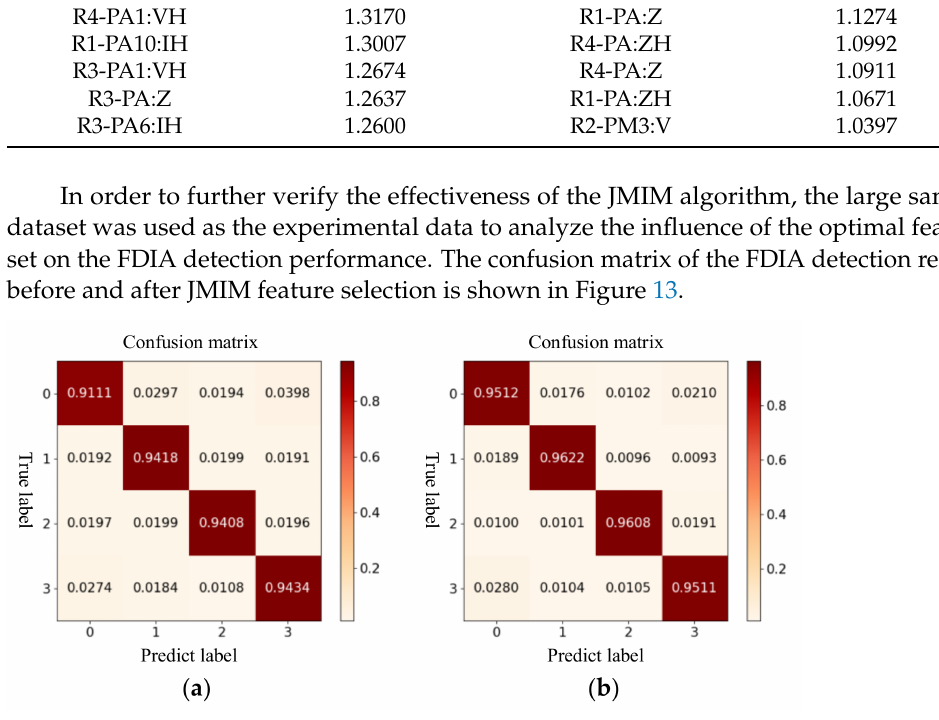
Figure 13. Comparison of FDIA detection results before and after feature selection. ( a ) Before feature selection; ( b ) after feature